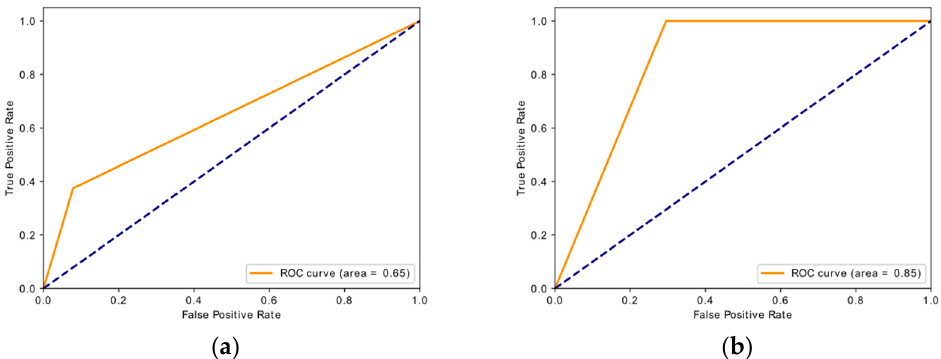
Figure A1. Detailed results of transfer learning from each source model after fine-tuning on the target dataset.